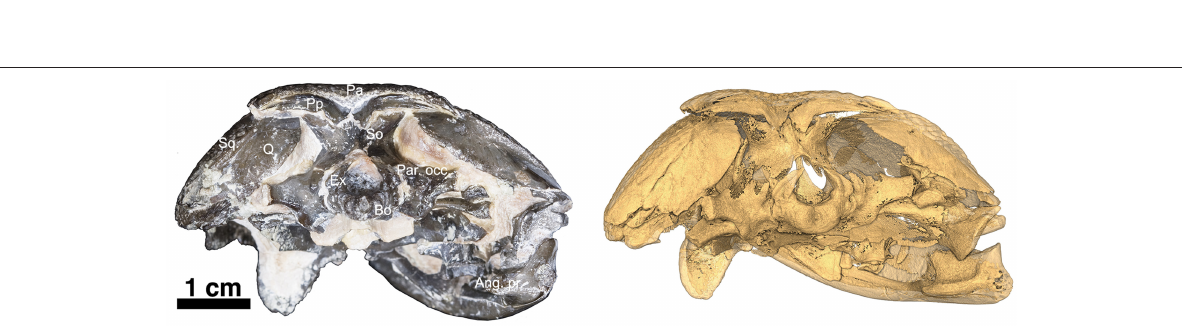
Frontiers in Earth Science |